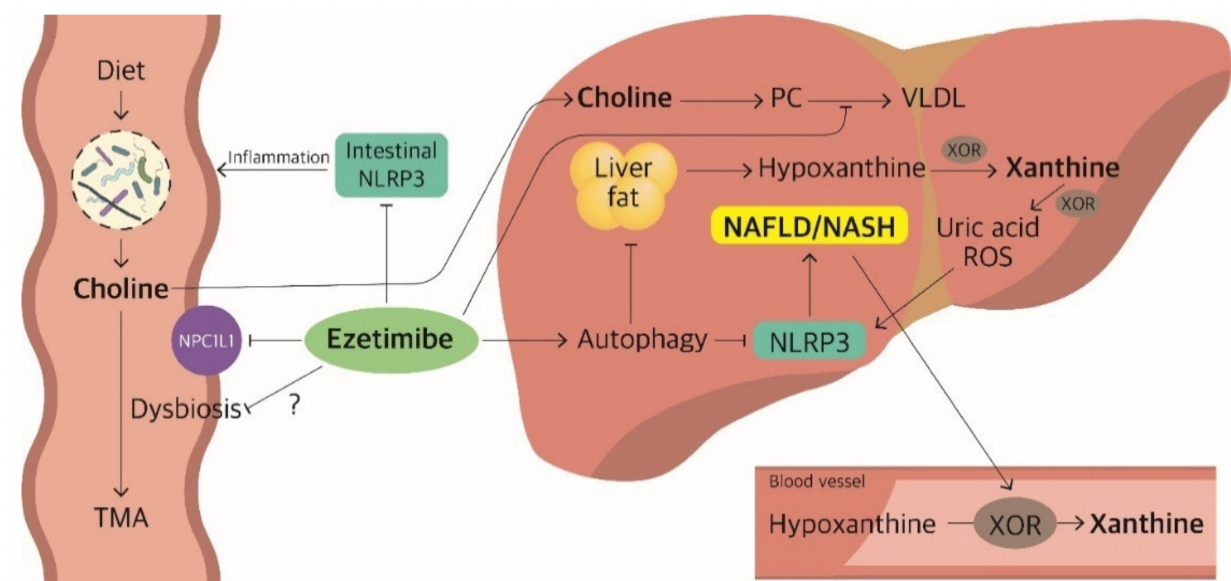
Figure 4. Putative schematic model of the relationships between the metabolites and ezetimibe. PC, phosphatidylcholine; VLDL, very-low-density lipoprotein; XOR, xanthine oxidoreductase; TMA, trimethylamine; NPC1L1, Niemann-Pick C1-Like 1; ROS, reactive oxygen species; NLRP3, NLR family pyrin domain containing